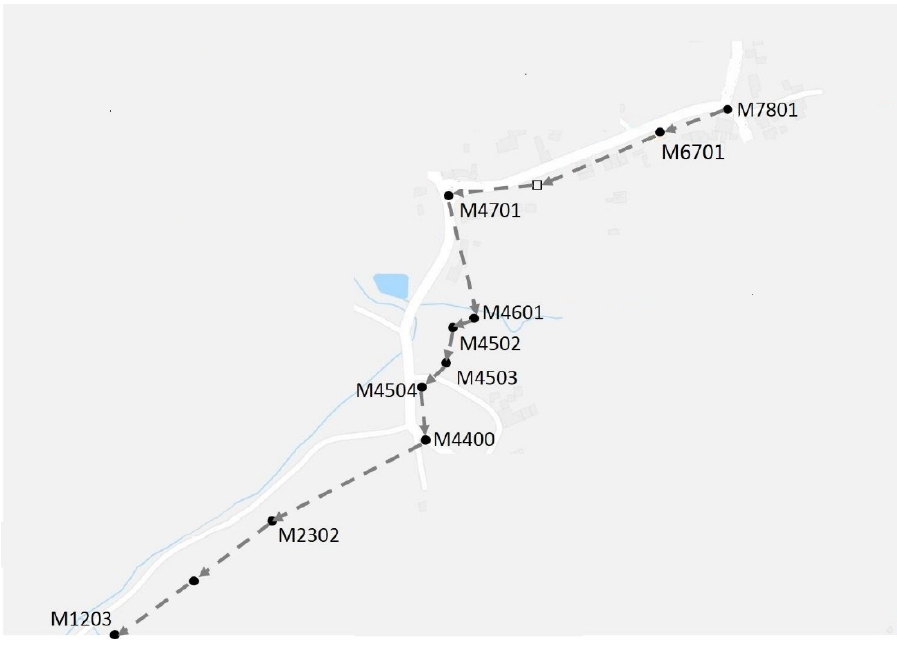
Figure 2. Surveyed section of the domestic foul sewer.